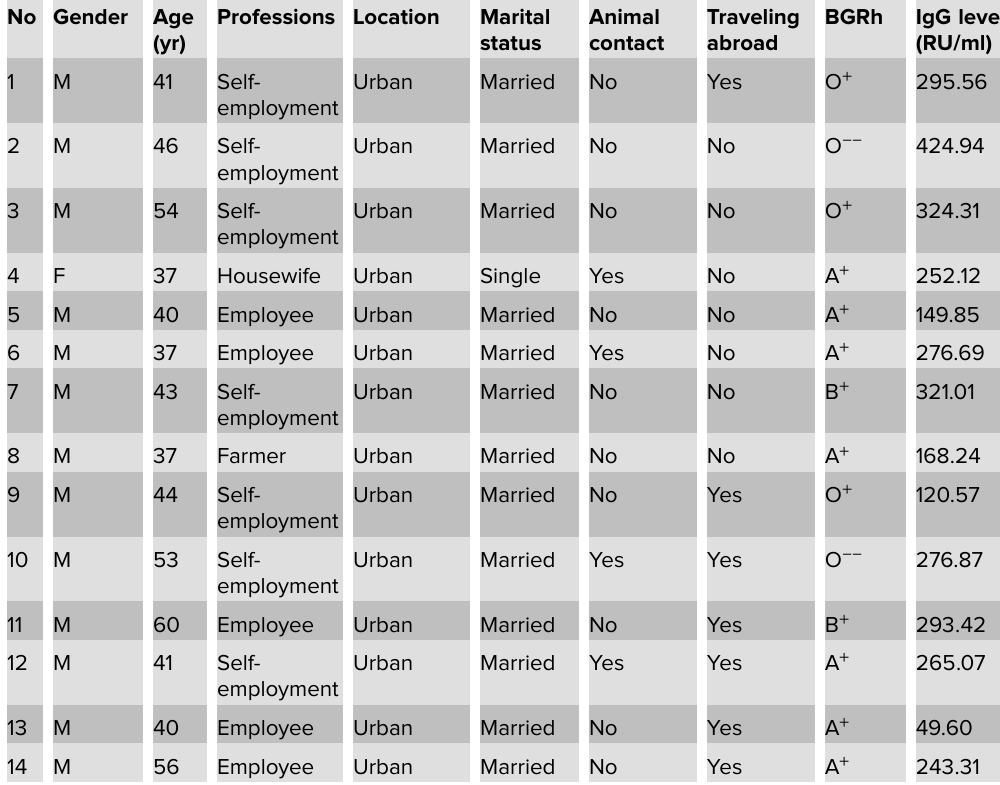
Table 2: The status of studied variables in blood donors with a positive IgG West Nile virus laboratory test. No Gender Age